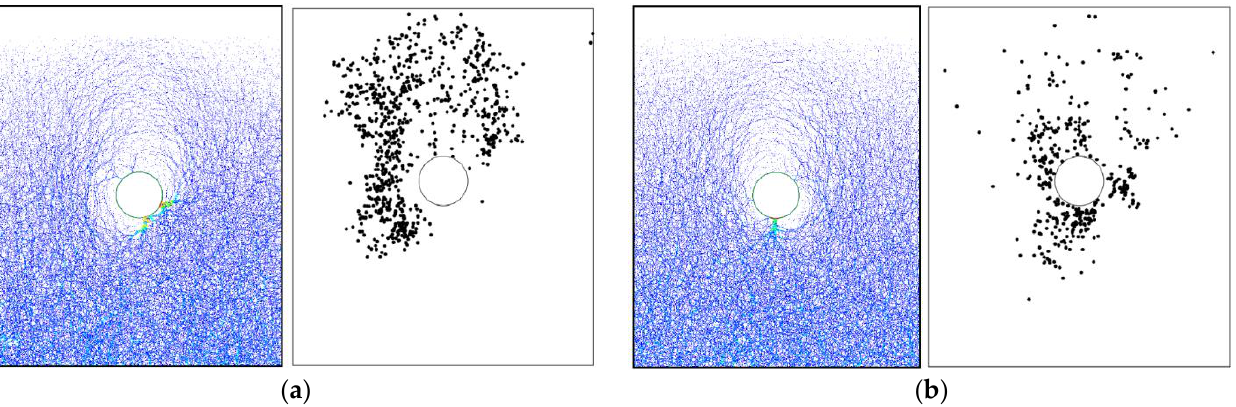
Figure 31. Force chains of the sandy ground and shear-slip contact distribution after excavation in the cases of ( a ) AR2C1 and ( b ) AR2C2.